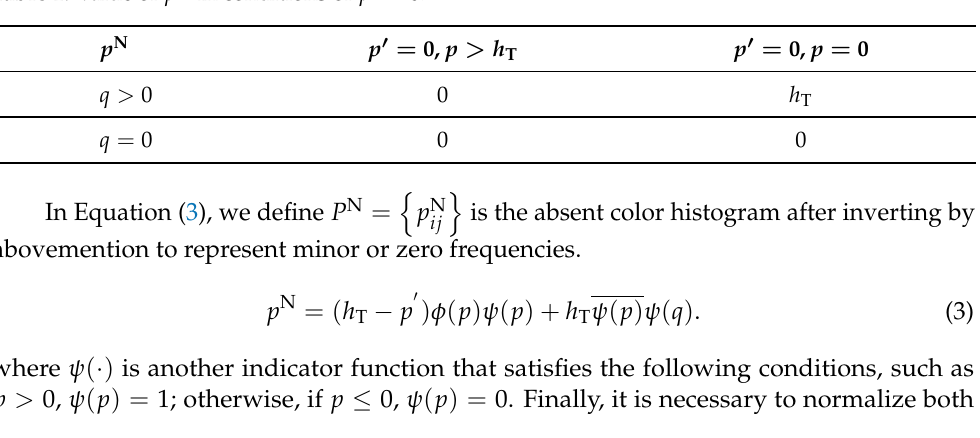
Figure 4. Explanation of how to deal with zero frequency p (cid:48) = 0 in the inverting process. ( a ) shows the case (1) when p (cid:48) = 0 and p > h T . ( b ) shows the cases (2) and (3) when p (cid:48) = 0, p = 0 and q > 0 or q = 0. Table 1. Value of p N in conditions of p (cid:48) =